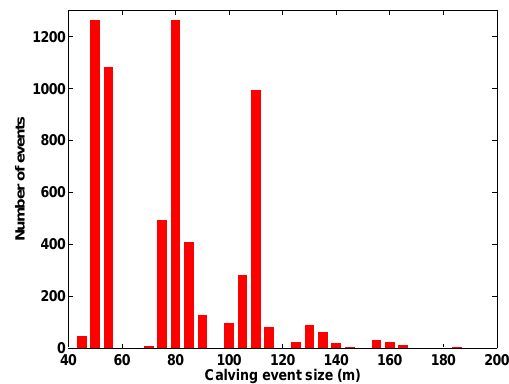
Figure 10. Distribution of the size of the calving events correspond- ing to the 12 realistic simulations. Different modes can be related to the different combinations of damage parameters. The axis repre- senting the calving event size is truncated at 200m. However, a few events, up to 2000m were